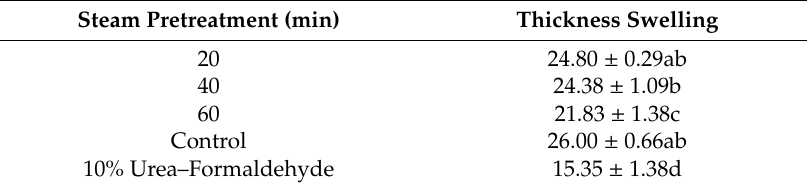
Table 4. Thickness swelling of particleboard made without synthetic adhesive with steam-pretreated particles.